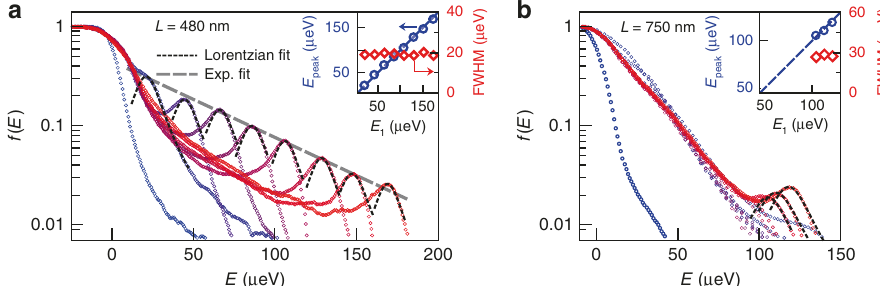
Fig. 3 Exponential decay and revival of the quasiparticle peak. Measured f ( E ) for L = 480 nm ( a ) and L = 750 nm ( b ), in semi-log scale. The circles are experimental data, with the same dataset as in Fig. 2, ranging from E 1 = { − 21, − 17 μ eV} (blue), to E 1 = {173, 121} μ eV (red). The black dashed lines are Lorentzian fi ts of the quasiparticle peak, and the gray dashed line in a is an exponential fi t of the maxima of the Lorentzian fi ts, with a characteristic energy E ≈ 56 μ eV. Insets: Center E y -axis) and full-width at half-maximum FWHM (red diamonds, right y -axis) of the Lorentzian fi ts, plotted d peak (blue circles, left versus injection energy E 1 . The size of the symbols indicates our experimental accuracy. The blue dashed line in the insets is a y = x